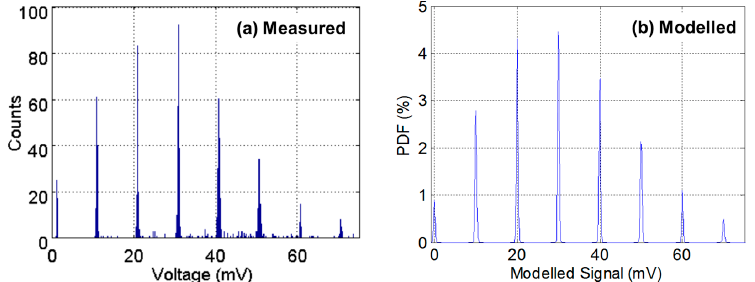
Figure 3. ( a ) Measured PCH of the analogue counting pixel test structure in [15]; ( b ) Modelled PCH with mean λ = 3 SPAD events, CVF equivalent of 10 mV/SPAD event and equivalent 0.02 e ´ RN.